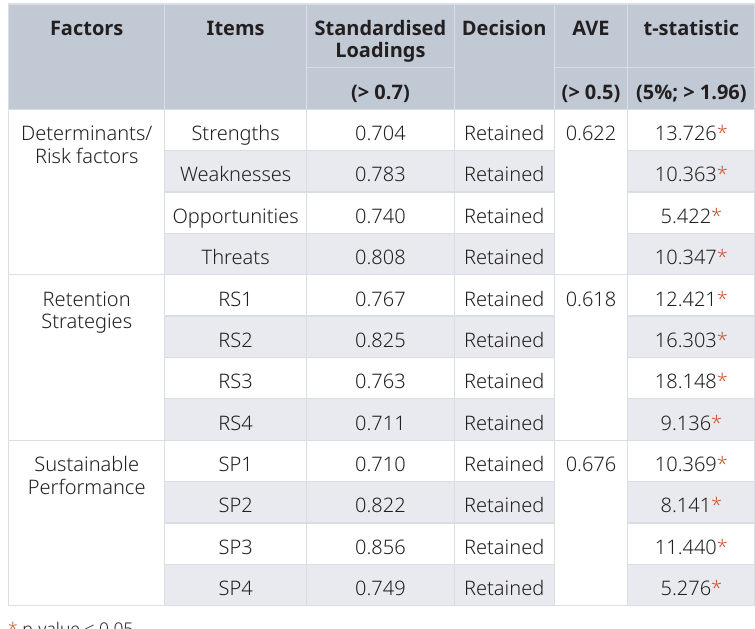
Table 2. Convergent validity results for each